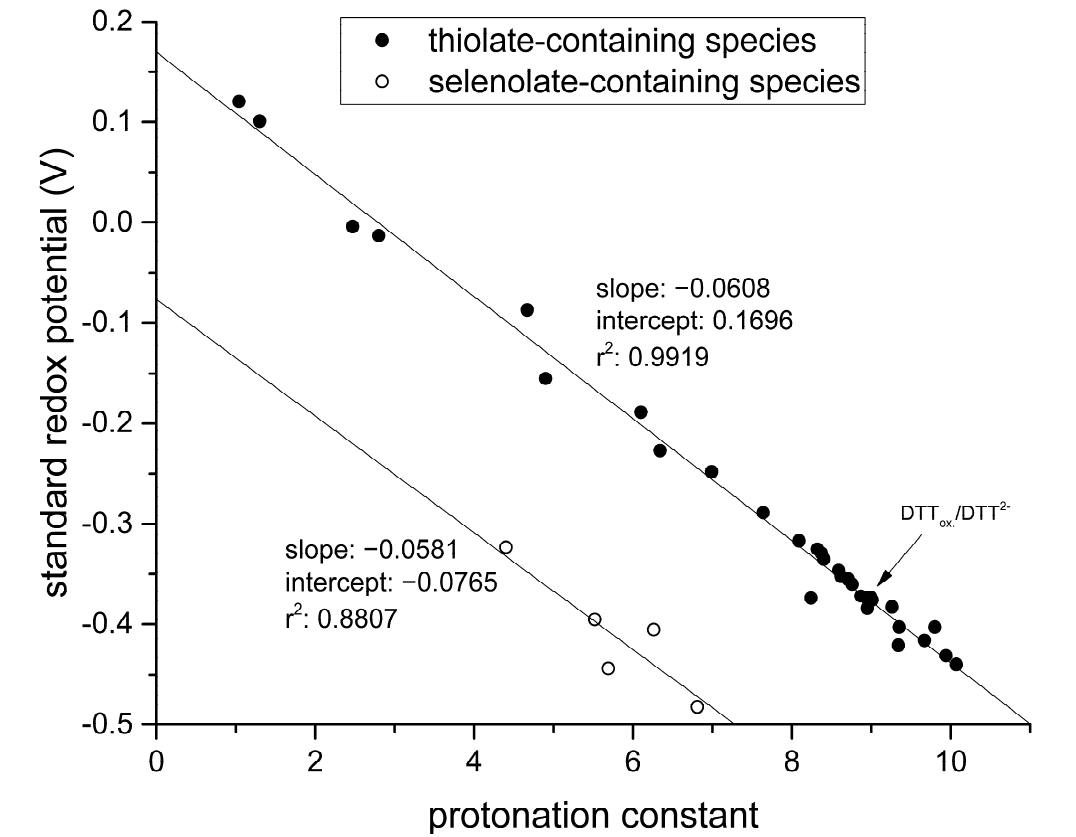
Figure 7. Correlation between standard redox potentials and species-specific thiolate protonation constants for various thiol-containing compounds (glutathione, cysteine, cysteamine, homocysteine, penicillamine, ovothiol A) reproduced from [4] with the addition of the data of dithiothreitol (upper line, full circles); the correlation between standard redox potentials and the species-specific selenolate protonation constants for the various selenol-containing compounds (lower line, empty circles).